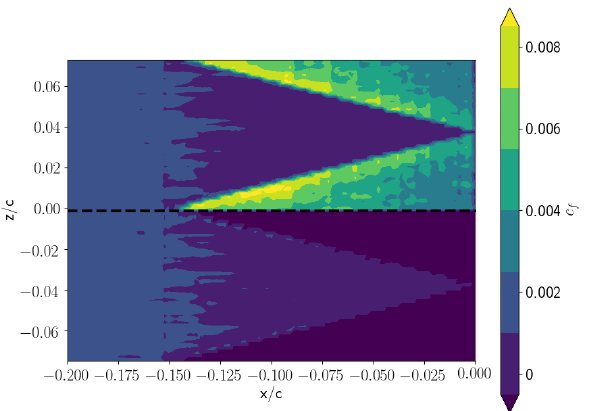
Figure 5. Distributions of c p ( left ) and c f ( right ) plotted against XFOIL [21] predictions. Dashed line indicates the inflow plane of the LES domain.